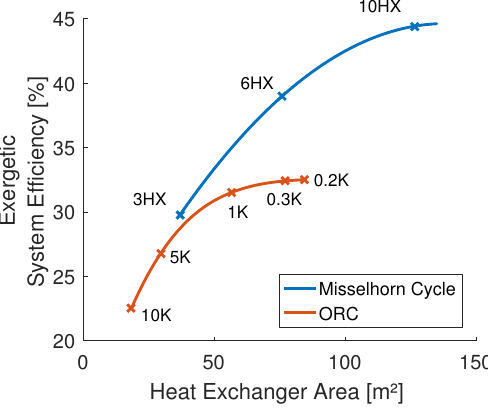
Figure 7. Comparison of the system efficiency depending on the evaporator pinch point (ORC) and the number of heat exchangers (MWM)).